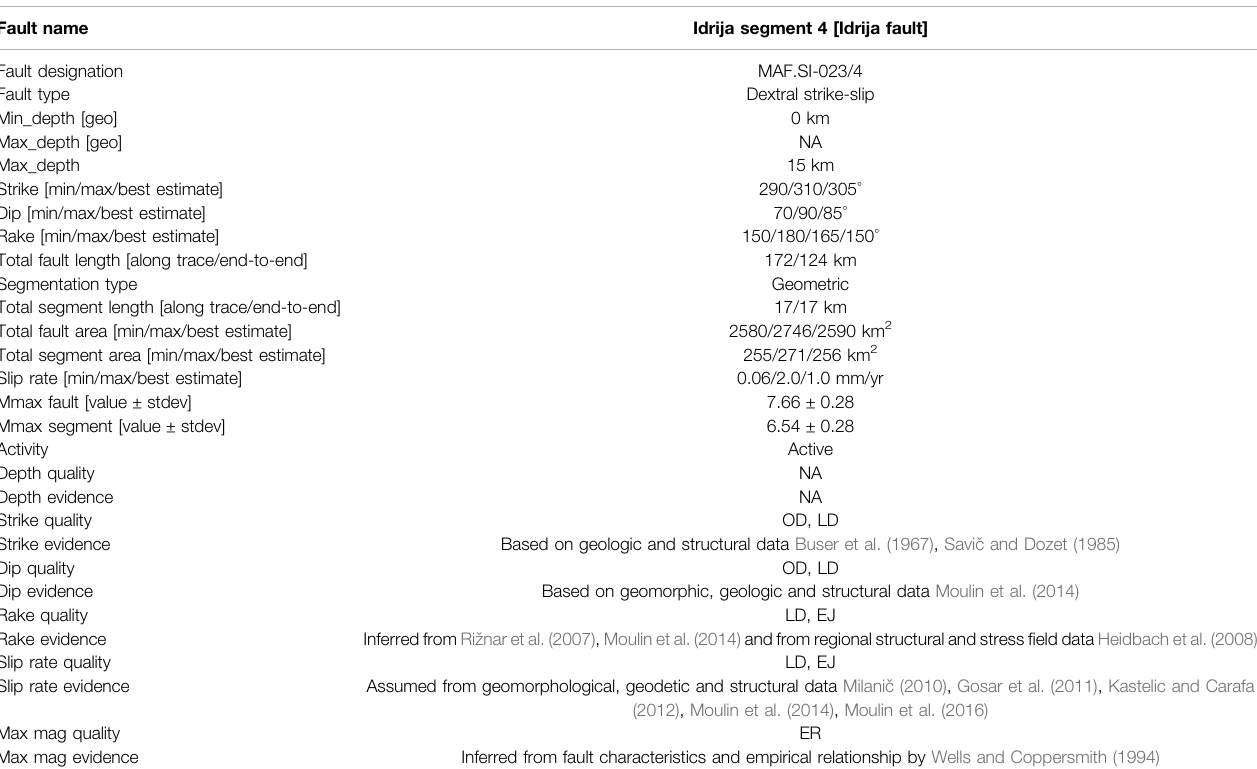
TABLE 2 | Fault segment parametrization example (Idrija